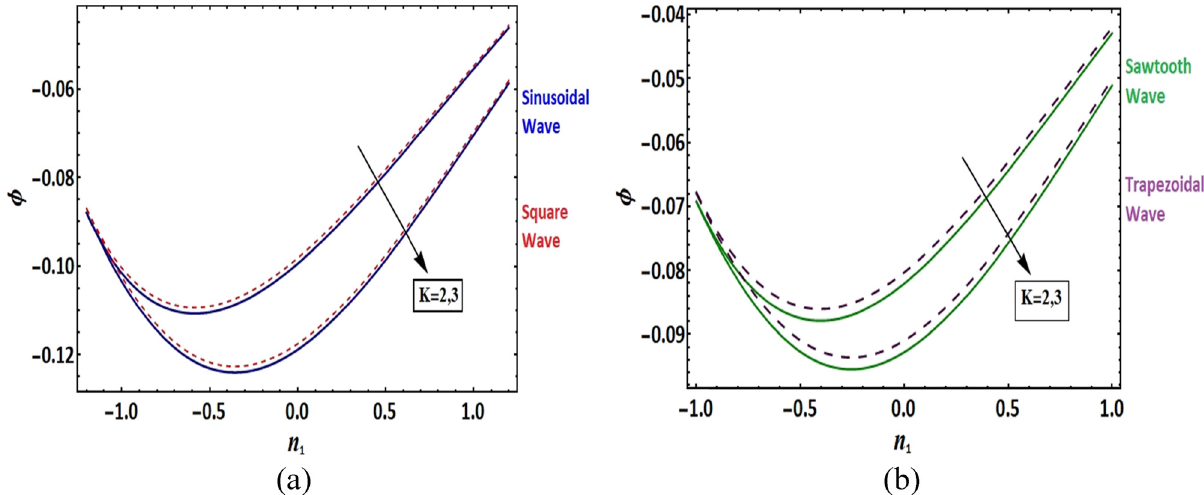
= 0.1, A = 2, Sr = 0.5, A 1 1